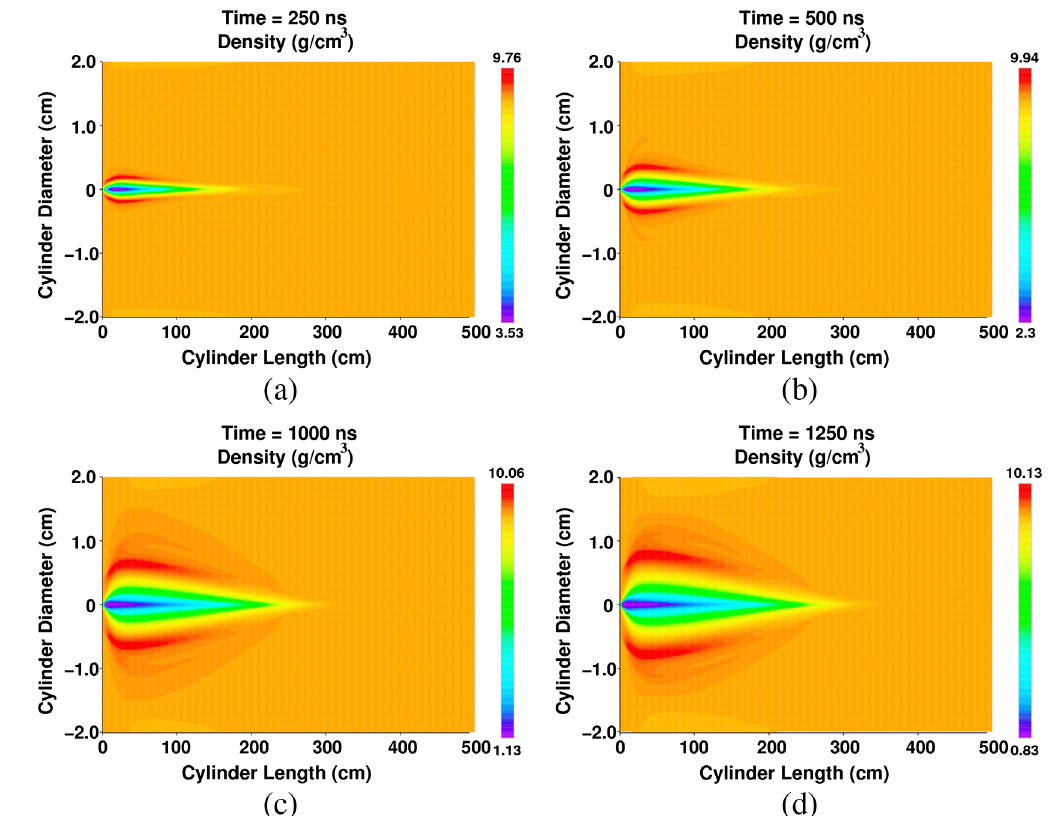
FIG. 9. Target density distribution calculated by BIG 2 (a) at t ¼ 250 ns (10 bunches delivered), (b) at t ¼ 500 ns (20 bunches delivered), (c) at t ¼ 1000 ns (40 bunches delivered), and (d) at t ¼ 1250 ns (50 bunches